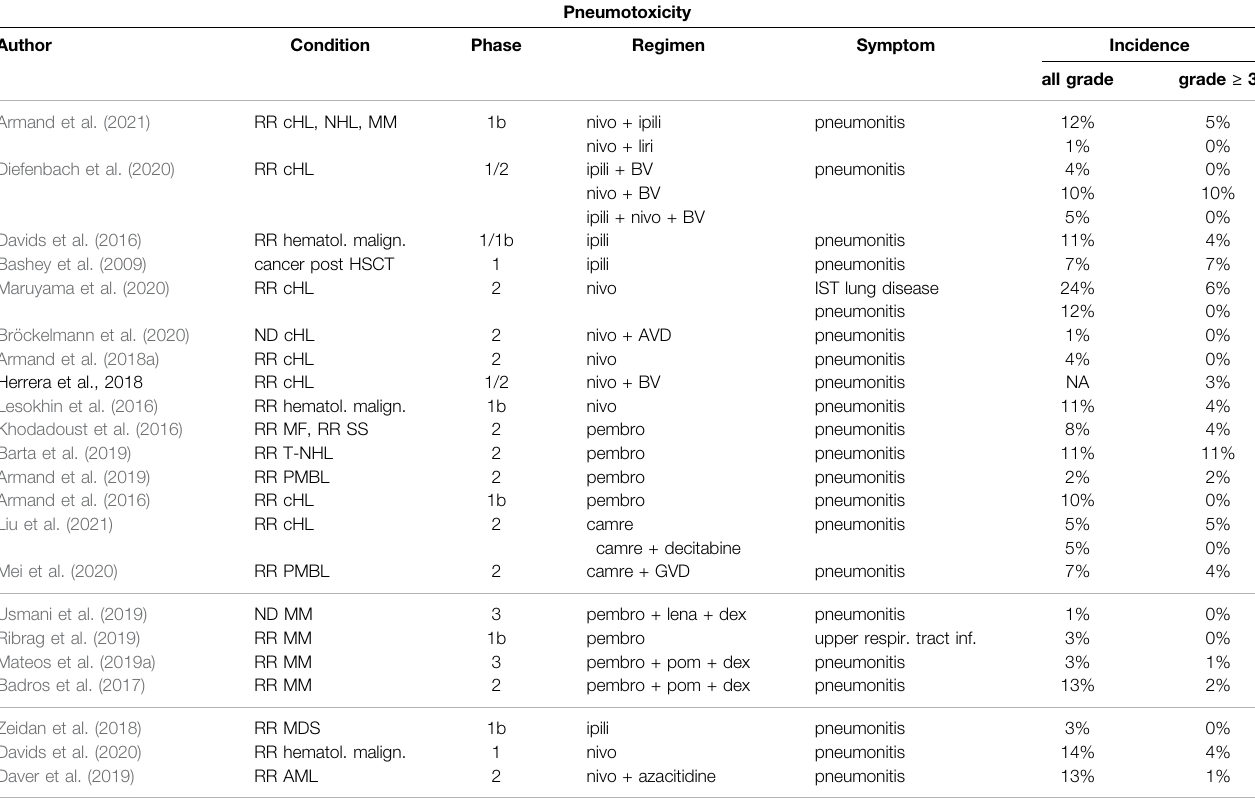
TABLE 5 | Incidence of pulmonary irAEs in hematological